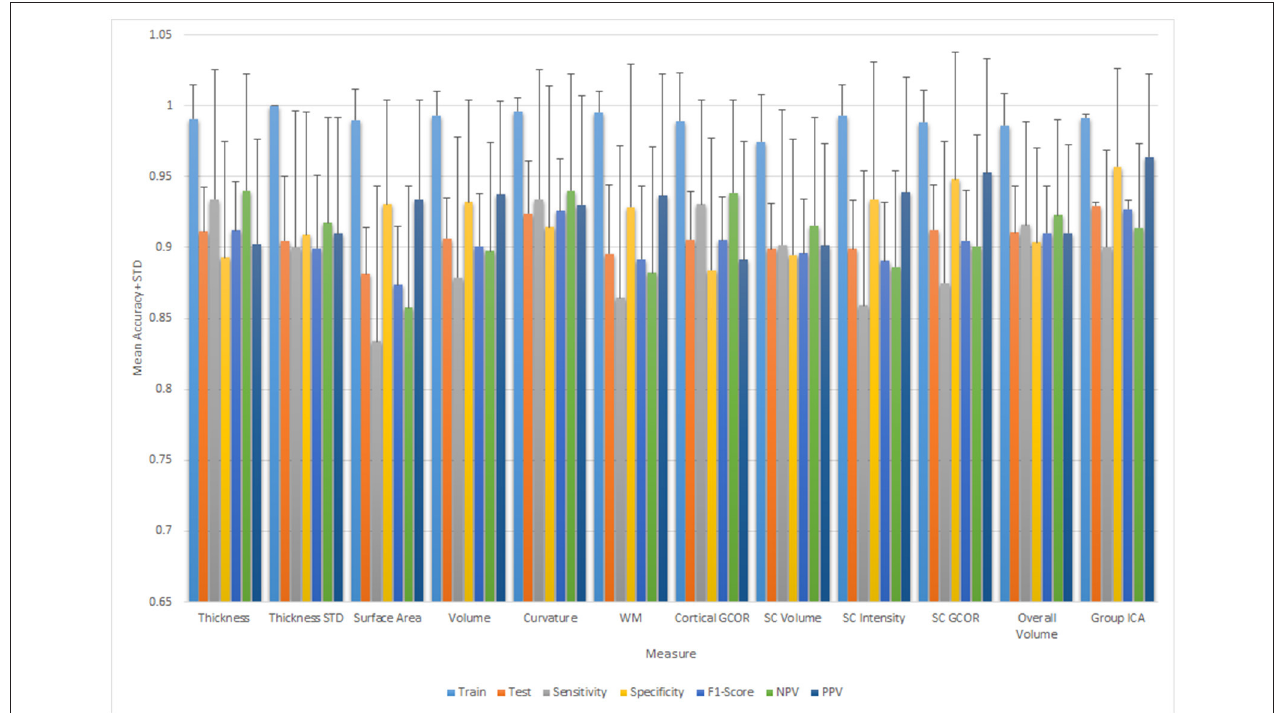
FIGURE 6 | Mean and standard deviation of the classification performance parameters for ELM.